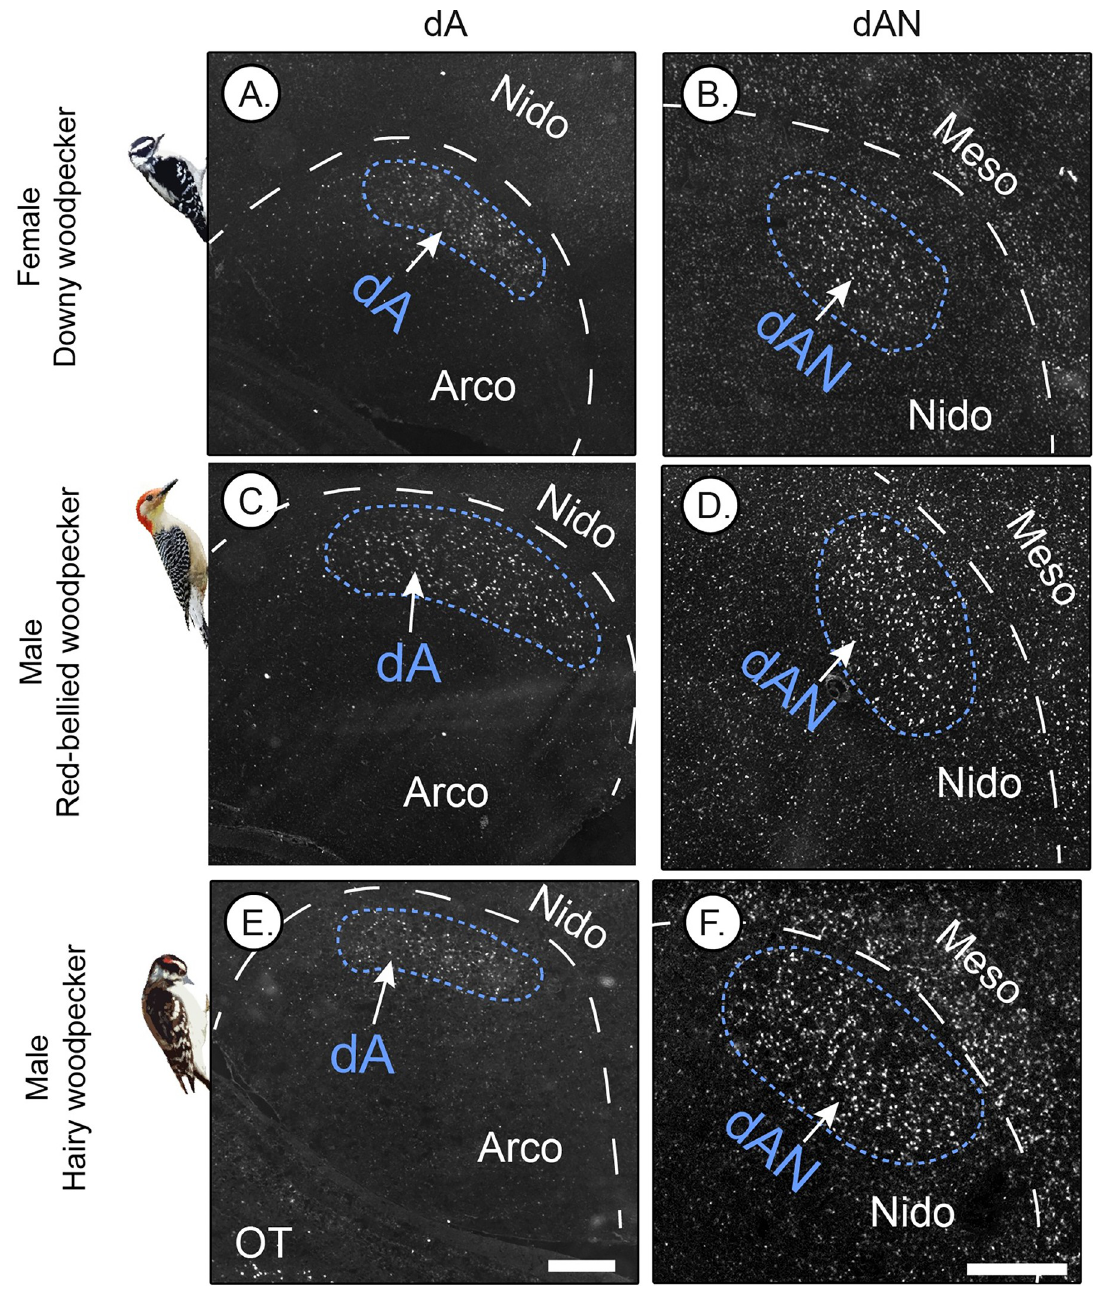
Fig 4. Parvalbumin ( PV ) specialization in dorsal arcopallial (dA) and nidopallial (dAN) nuclei in female downy woodpeckers, as well as 2 other woodpecker species. (A, B) Female downy woodpecker. (C, D) Male red-bellied woodpecker. (E, F) Male hairy woodpecker. Shown are representative in situ hybridization microscope images (inverted black and white colormetric) of PV expression (white), with fast red as a counterstain (grey). Nido, nidopallium; Meso, mesopallium; Arco, arcopallium; Ot, optic tectum. Scale bars = 500 μ m. White dashed lines in images indicate boundaries for different telencephalic regions. White dashed lines in high- magnification images indicate boundaries for different telencephalic regions (e.g., boundary between nidopallium and mesopallium), whereas blue dashed lines indicate specialized PV regions identified in woodpeckers. Photo credits : Female downy woodpecker from Ken Thomas (Public Domain via WikiMedia); male red-bellied woodpecker from Neal Lewis (Public Domain Mark 1 . 0 via Flickr); and male hairy woodpecker from David Whelan (Public Domain via WikiMedia)